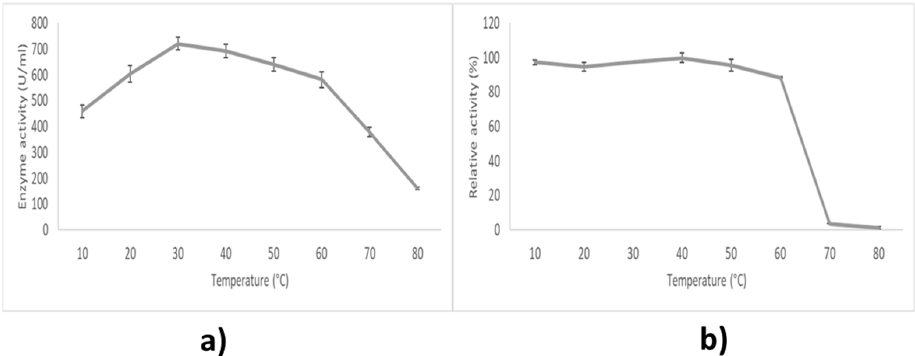
Figure 6. Effect of temperature on LIP2 lipase. ( a ) Effect of temperature on lipase activity. The lipase assay was tested at different temperatures (10–80 ◦ C). ( b ) The effect of temperature on lipase stability. The enzyme was pre-incubated beforehand at various temperatures (10–80 ◦ C) in 30 min. The relative activity was calculated based on the percentage of the highest activity. Error bars indicate standard deviation of means ( n = 3). Absence of bar indicates that errors were smaller than the symbols and lines.